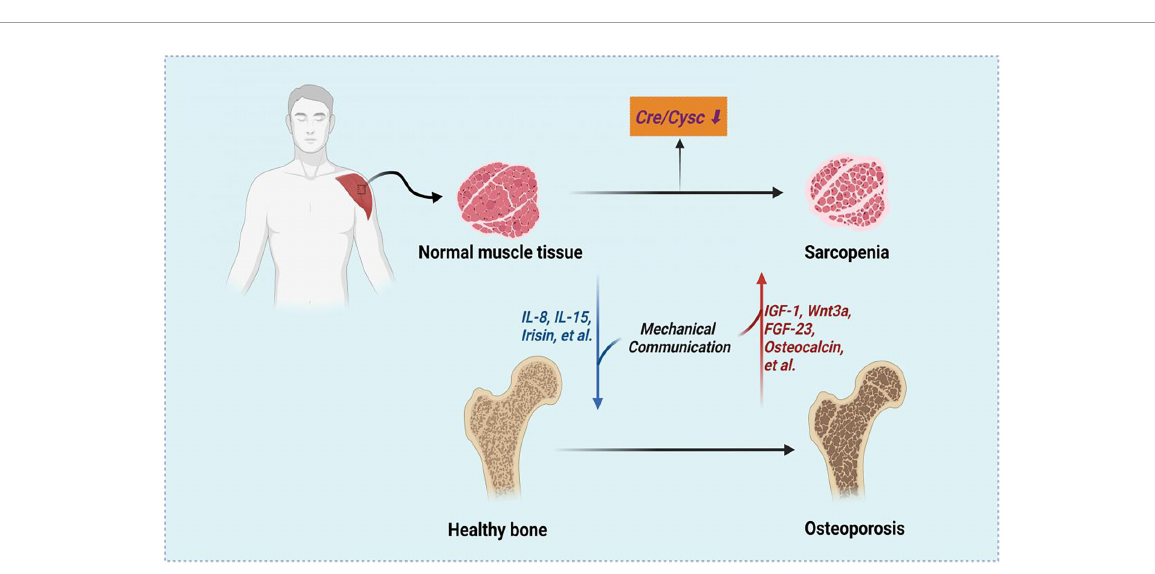
control, and a significant negative correlation was observed with the TH